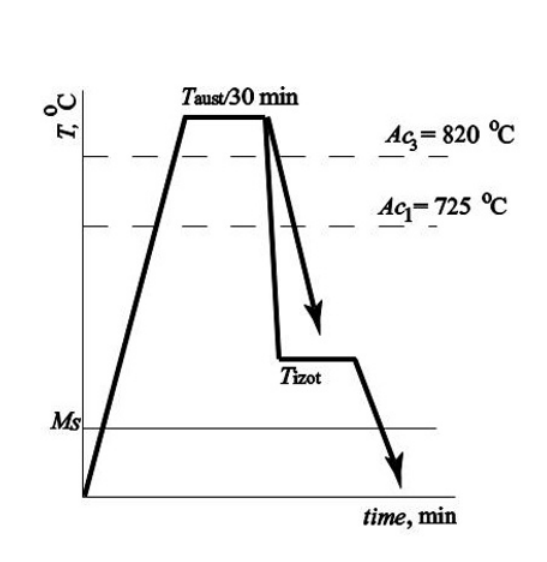
Figure 1. Scheme of heat treatment of the steels.